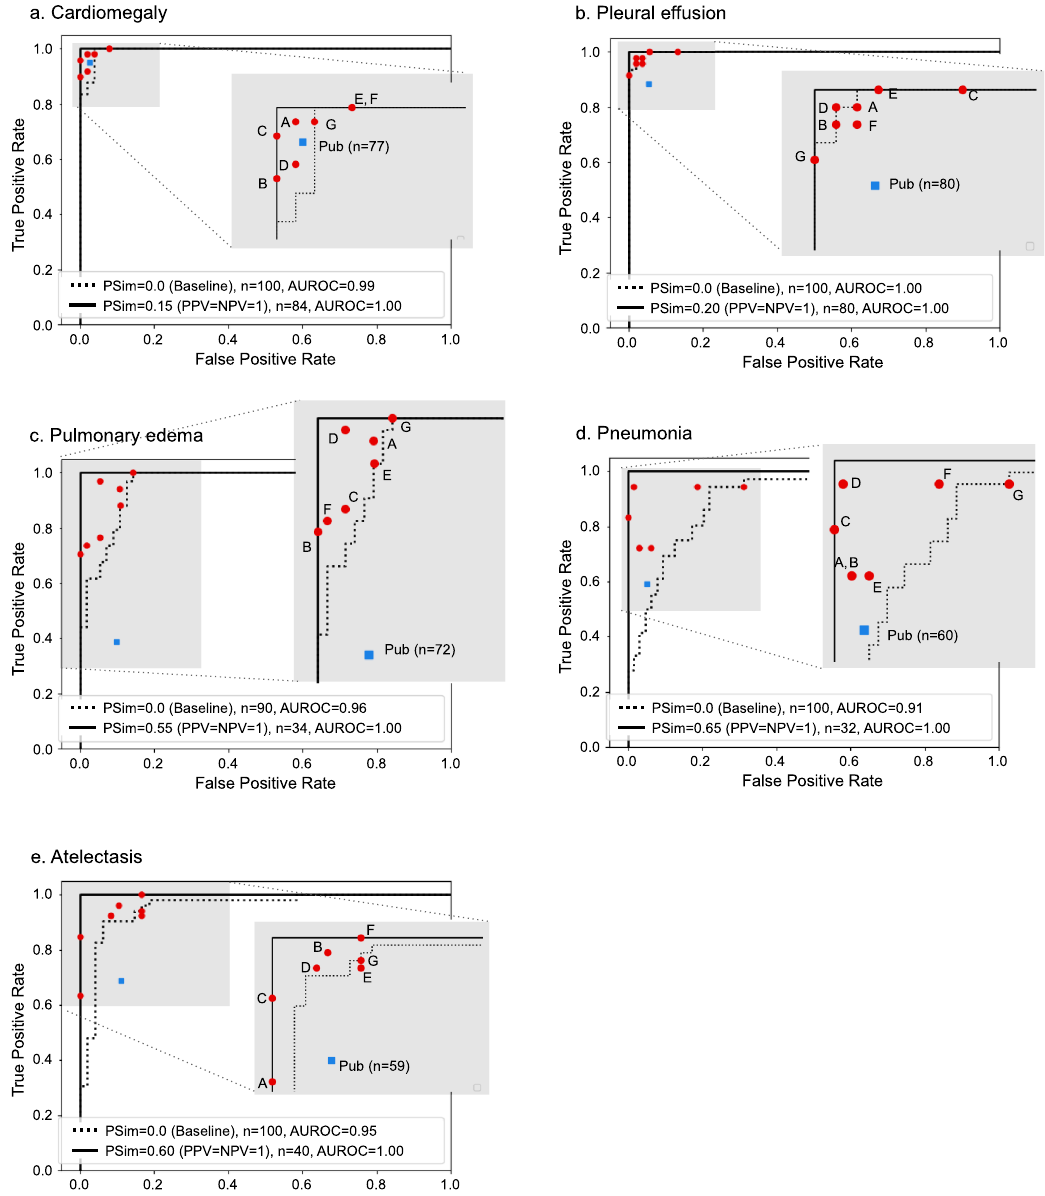
Fig. 5 AUROC performance of automated-labeling model at two different pSim threshold values, compared to sensitivity, speci fi city of individual expert radiologists, and pooled public labels from three open-source CXR datasets. AUROC performance of our xAI CXR auto-labeling model applied to the CheXpert, MIMIC, and NIH open-source datasets, is shown for each of the fi ve labeled clinical output labels: a cardiomegaly, b pleural effusion, c pulmonary edema, d pneumonia, and e atelectasis. Comparison is to the performance of the individual expert radiologists (A – G, red circles), as well as to the performance of the pooled external annotations (blue squares, n = number available labeled external cases per clinical output label). ROC curves (y- axis sensitivity, x-axis 1-speci fi city) are shown for both the baseline pSim = 0 threshold (magni fi ed box) and the optimal pSim threshold (i.e., the lowest pSim threshold achieving 100% accuracy, as per Figs. 2 – 4c and